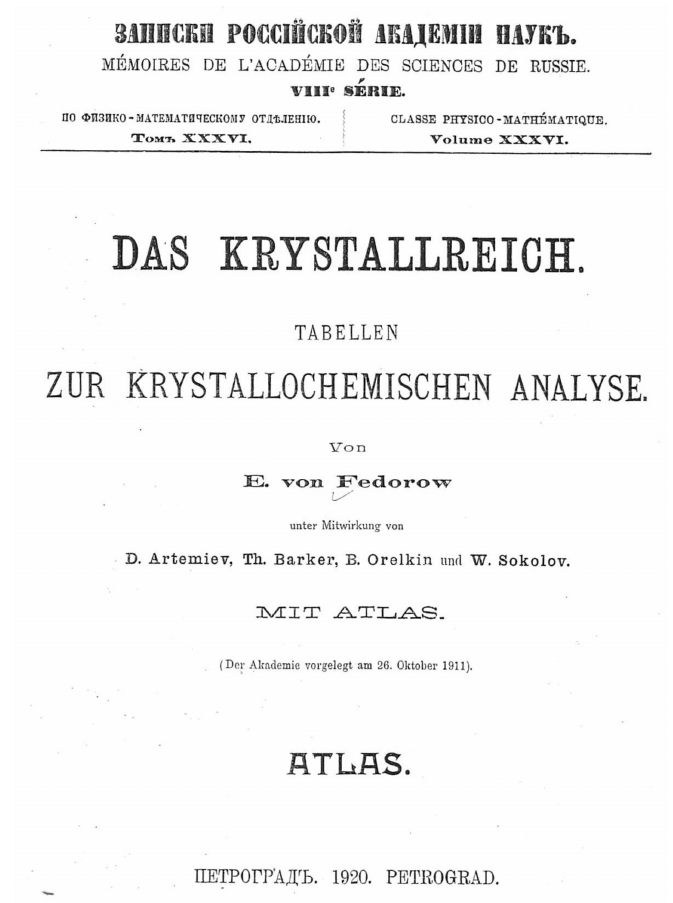
Figure 10. E. v. Fedorov, Title page of “Das Krystallreich.” (“The realm of crystals.”) Petrograd 1920